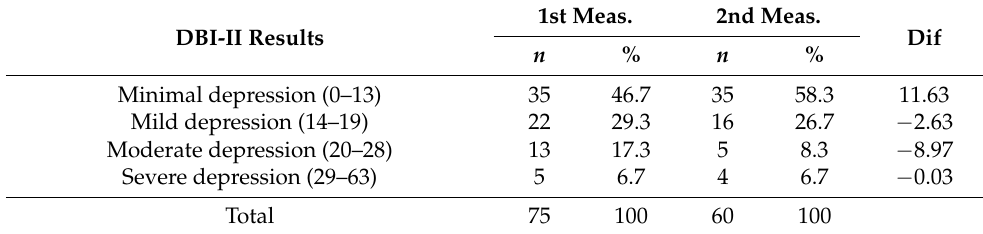
Table 8. Frequency of BDI-II test